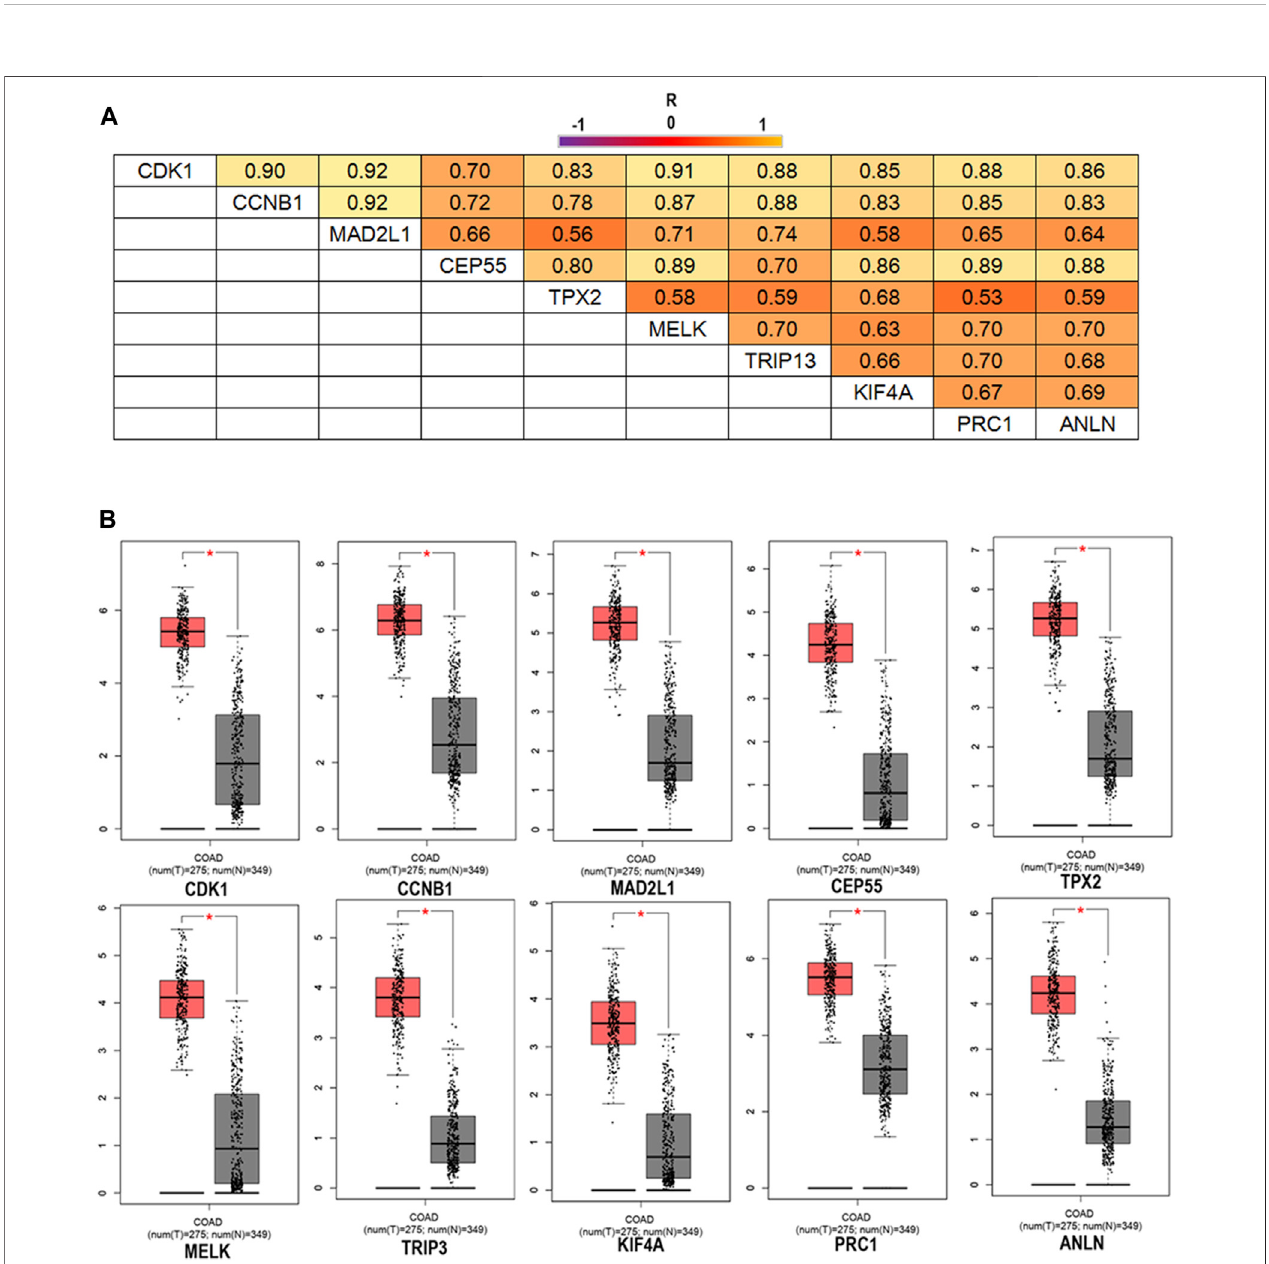
FIGURE3| Thecorrelationanalysisofthe10hubgenesinCRC (A) andexpressionlevelsofthe10hubgenesinCRCcomparedtothenormalsamples (B) .Notes: R is the Pearson correlation coef fi cient. Abbreviations: CRC, colorectal cancer.